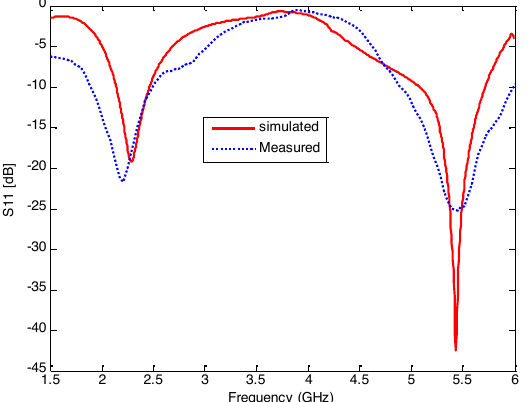
Fig .10. Measured return loss of the antenna with AMC in comparison to the antenna in free